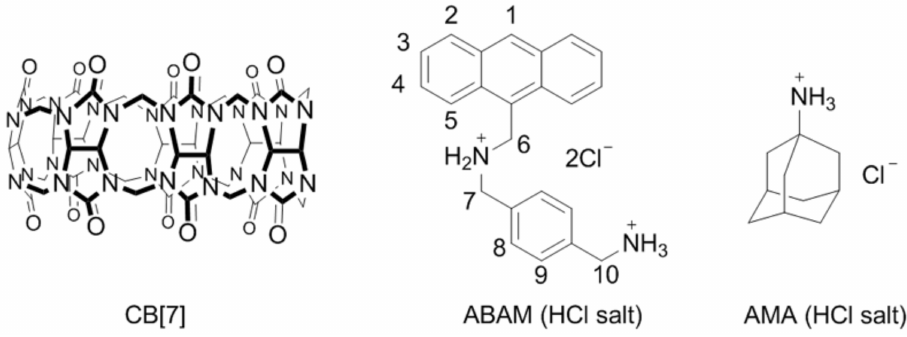
Figure 1. The structures of CB[7], ABAM, and